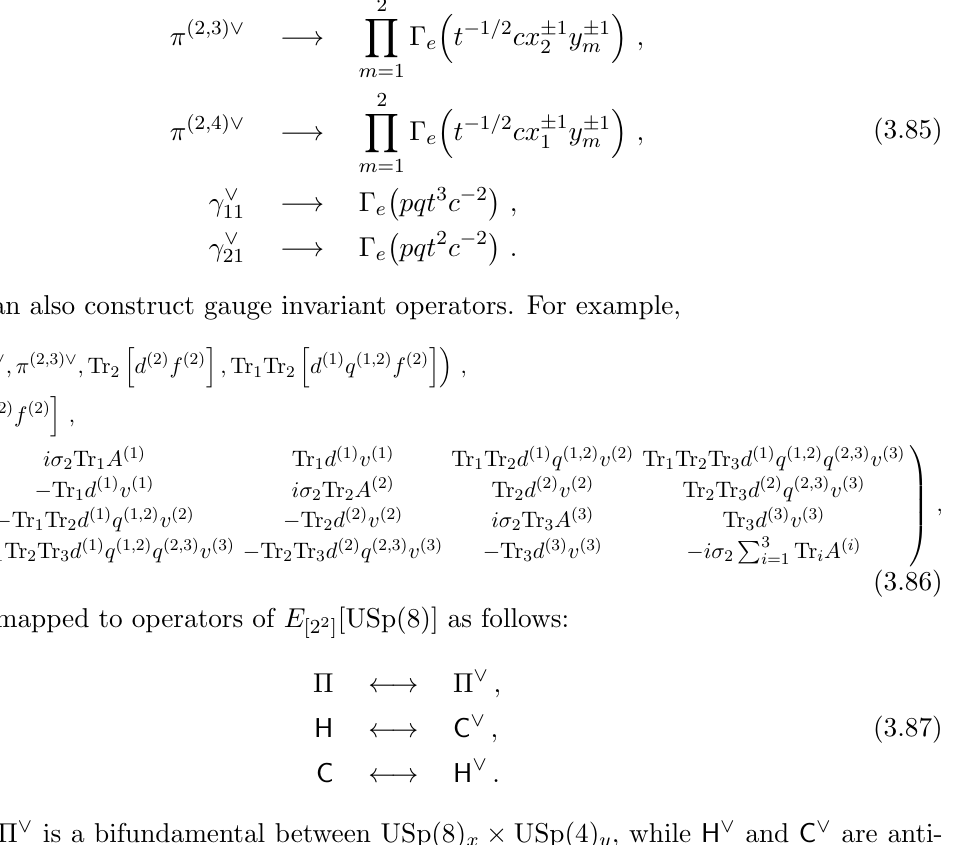
Figure 22 . The quiver diagram representation of E [2 2 ] [USp(8)]. Two (cid:13)ipping (cid:12)elds (cid:13) _ denoted by crosses, (cid:13)ip Tr 1